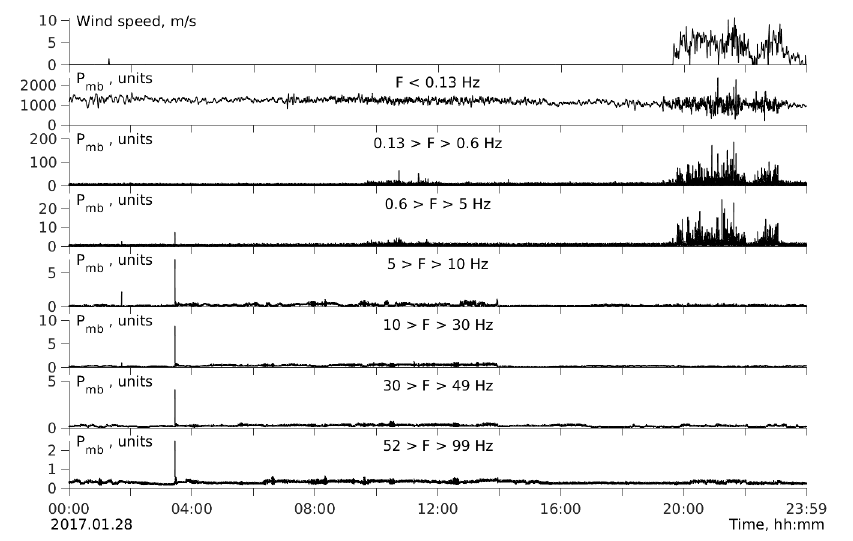
Figure 1: Example of wind e ff ect on atmospheric acoustic signal variations P mb recorded by the microbarograph in di ff erent frequency sub-ranges